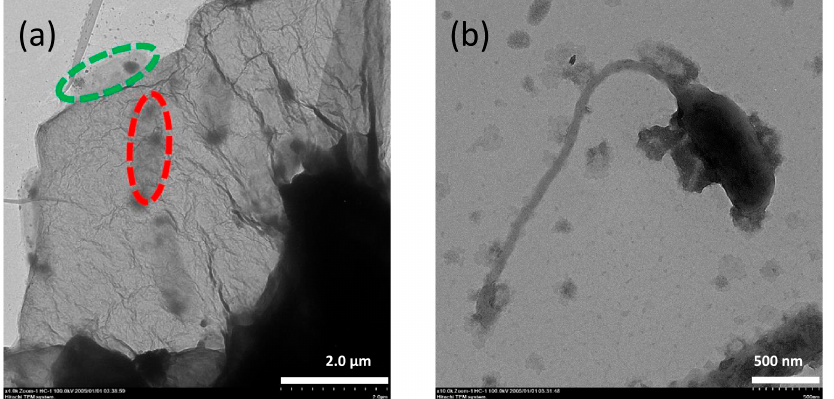
Figure 3. TEM images of ( a ) S. decolorationis NTOU1 cells with rGO, and ( b ) a cell with a bacterial- nanowire- or flagellum-like appendage (green, cells locating on the edge; red, cells depositing on the GO/rGO